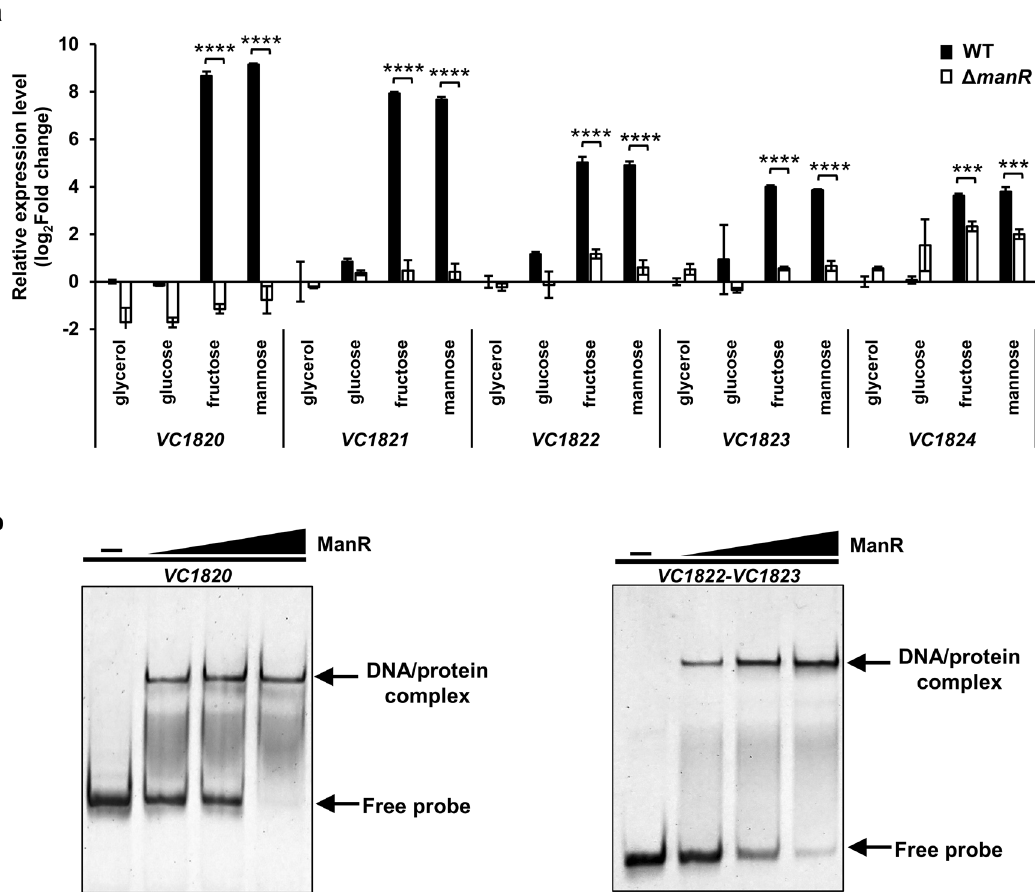
Fig. 7 ManR regulates the transcription of VC1820 to VC1824 genes as well as the man operon and itself. a Relative mRNA expression of VC1820 to VC1824 genes in the WT and manR deletion mutant in the presence of indicated sugars. The mRNA expression levels of indicated genes are shown as relative values (log 2 scale) to that of the WT strain grown on glycerol. The means and standard deviations of the three independent measurements are shown. Statistical signi fi cance was determined using the Student ’ s t -test (*** P < 0.0005 and **** P <